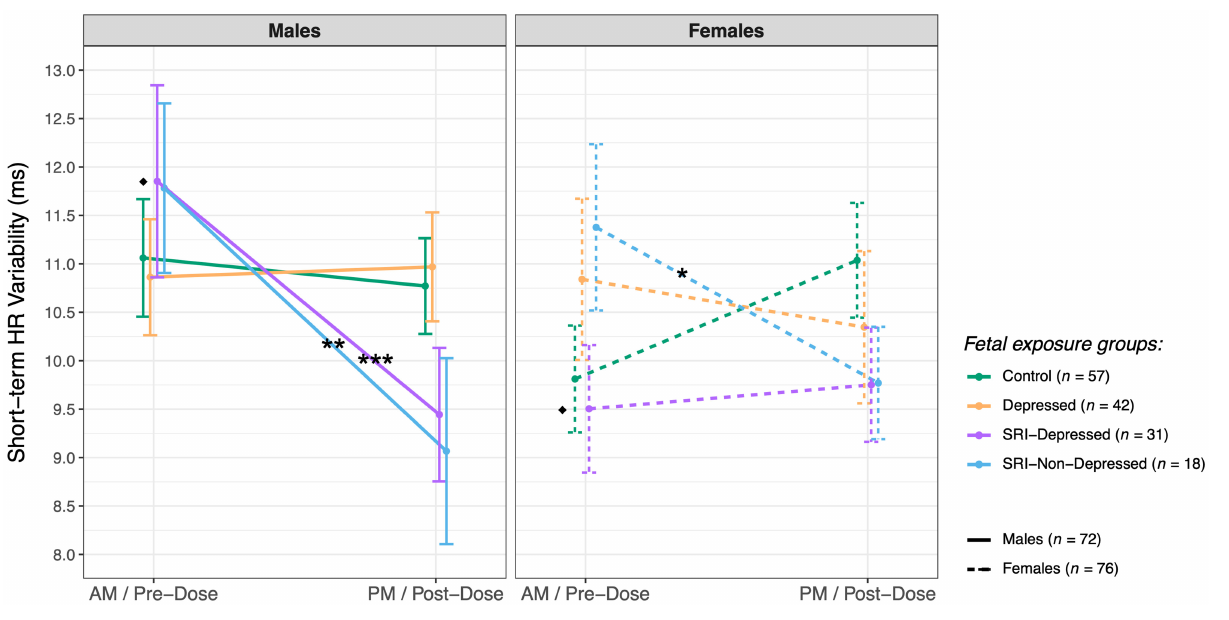
( t = 6.8, p < 0.001); this also did not differ between groups, nor across assessments. There were no covariate effects on